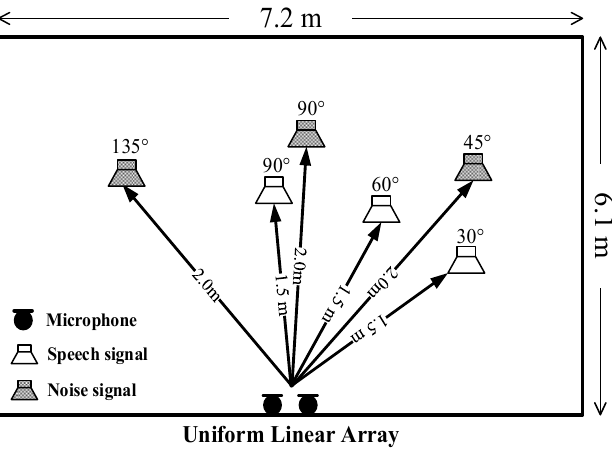
Figure 4. Layout of chamber to the developed system.